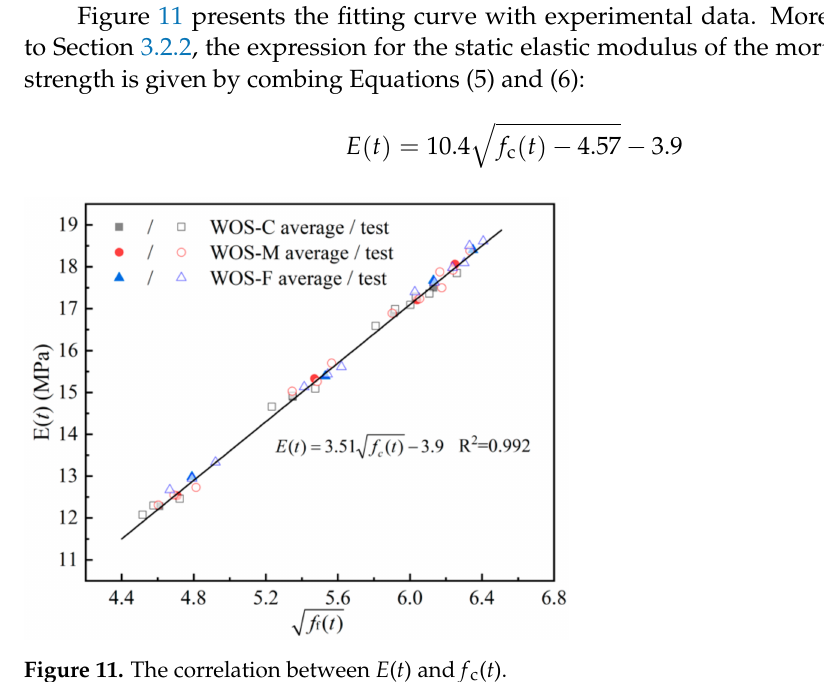
Figure 11. The correlation between E ( t ) and f c ( t